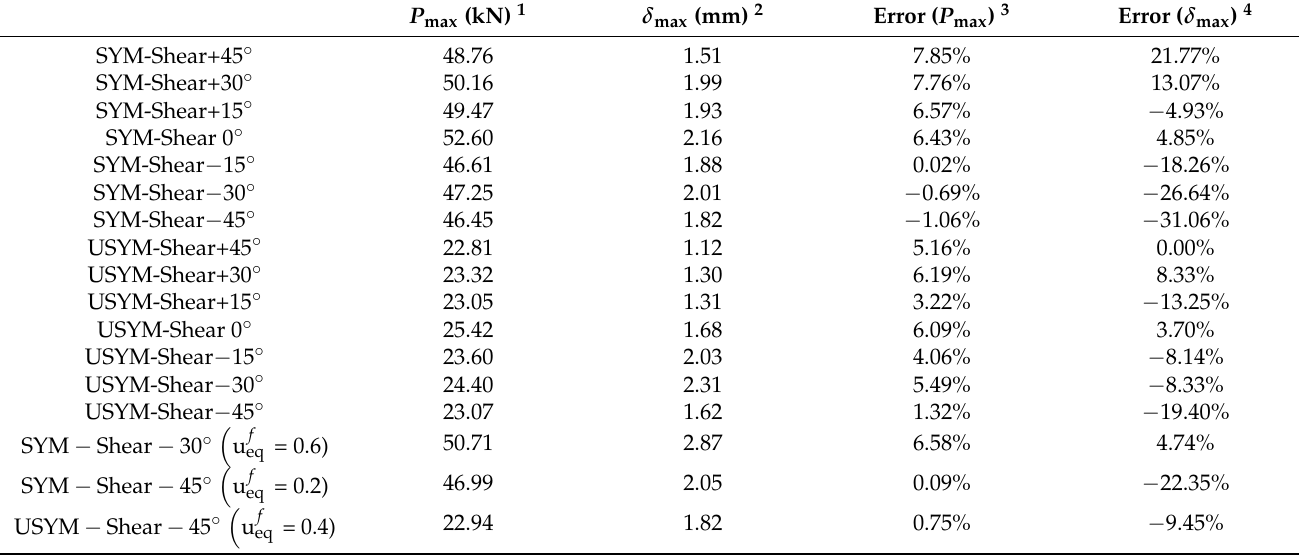
Table 4. Analysis results using the modified N-VG model.